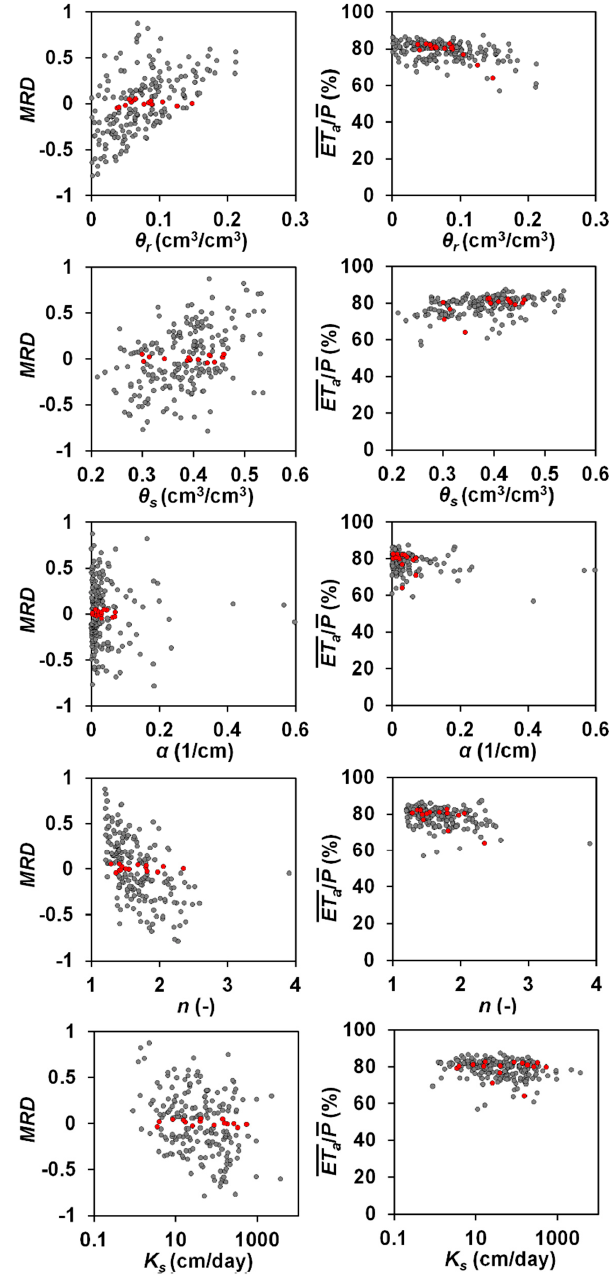
Figure 6. Relationships of MRD and ET a / P with di ff erent soil hydraulic parameters for sandy loam at Guiyang. Samples with MRD < ±0.05 are highlighted in red.